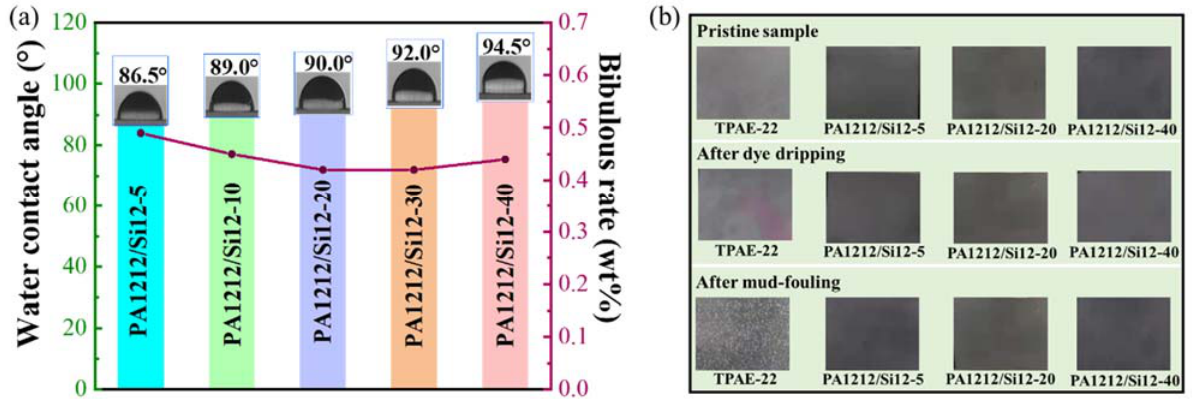
Figure 6. ( a ) Water contact angle of PA1212/Si12 copolymers; ( b ) The digital images for copolymers and TPAE ‐ 22 after dye dripping and mud contamination tests.